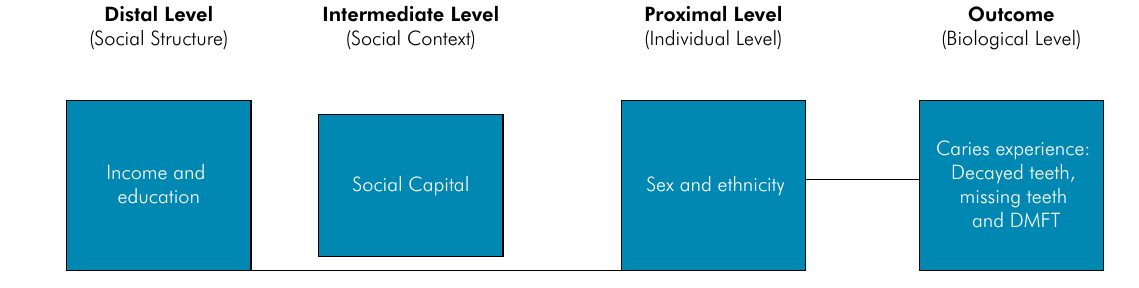
Figure. Conceptual model adapted from Holst et al.